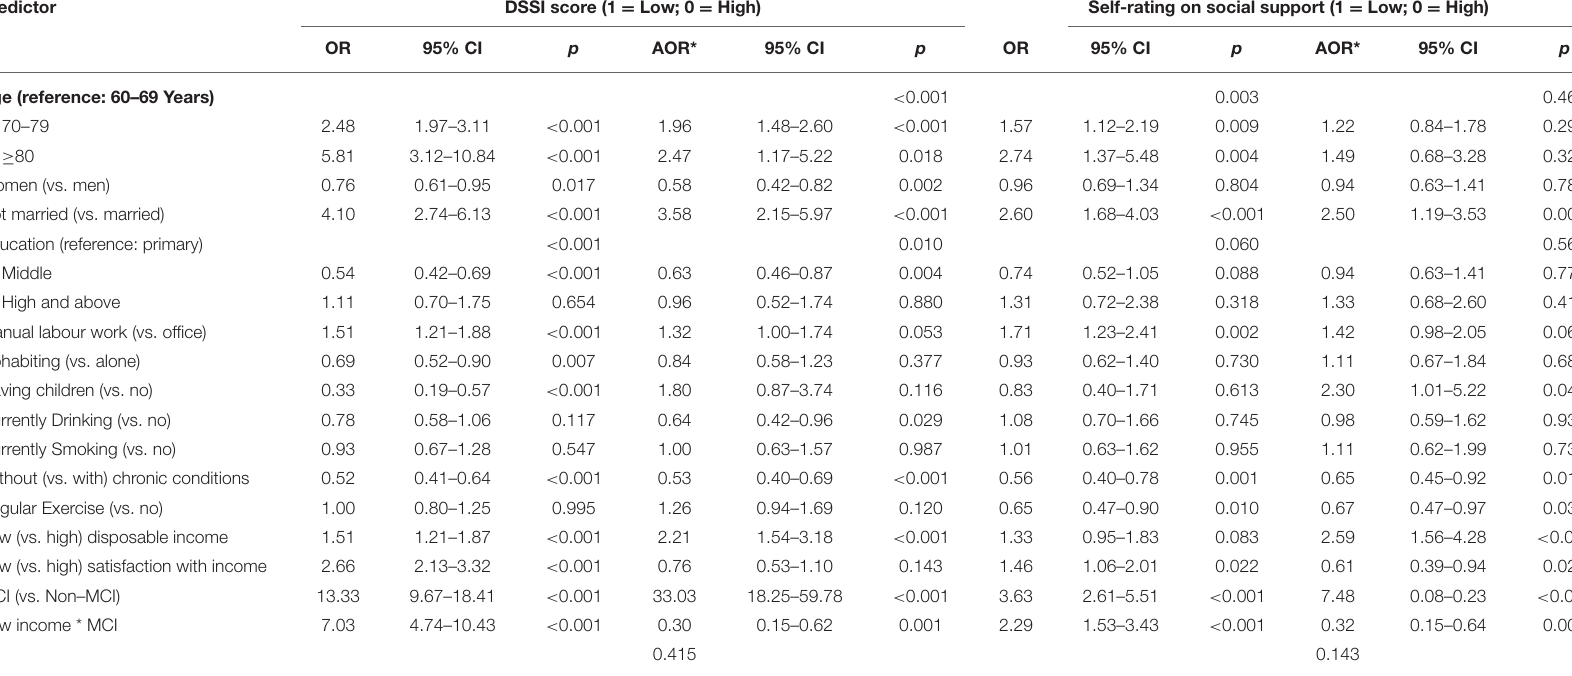
TABLE 4 | Logistic regression results of factors associated with social support.